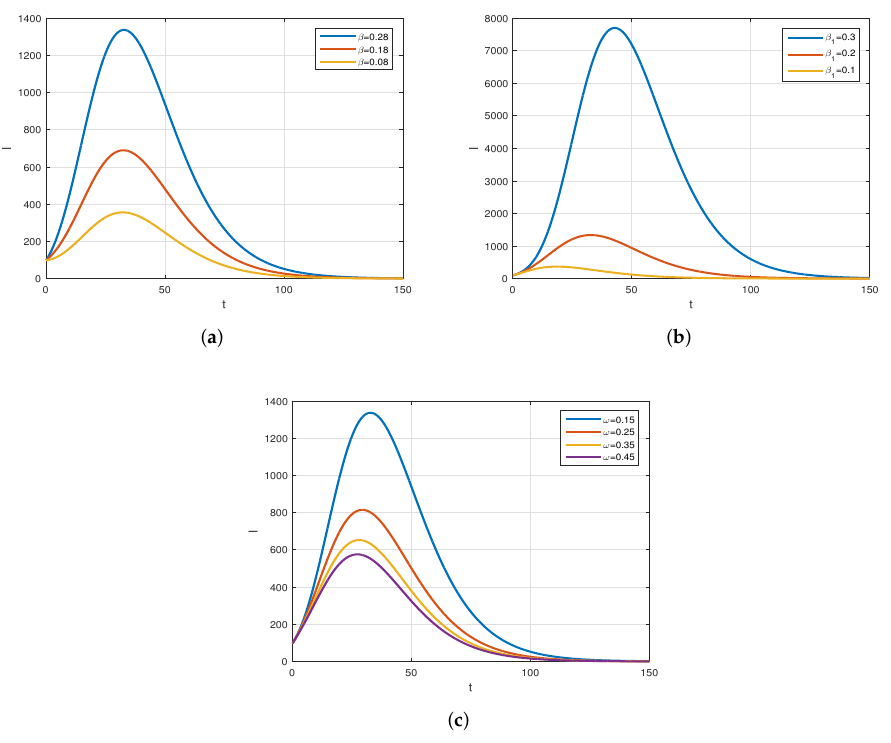
Figure 6. The behavior of the infected population for different values of β , β 1 , and ω . Subfigure ( a ) shows different values of β , while Subfigure ( b ) is given for various values of β 1 , and ( c ) is given for various values of ω